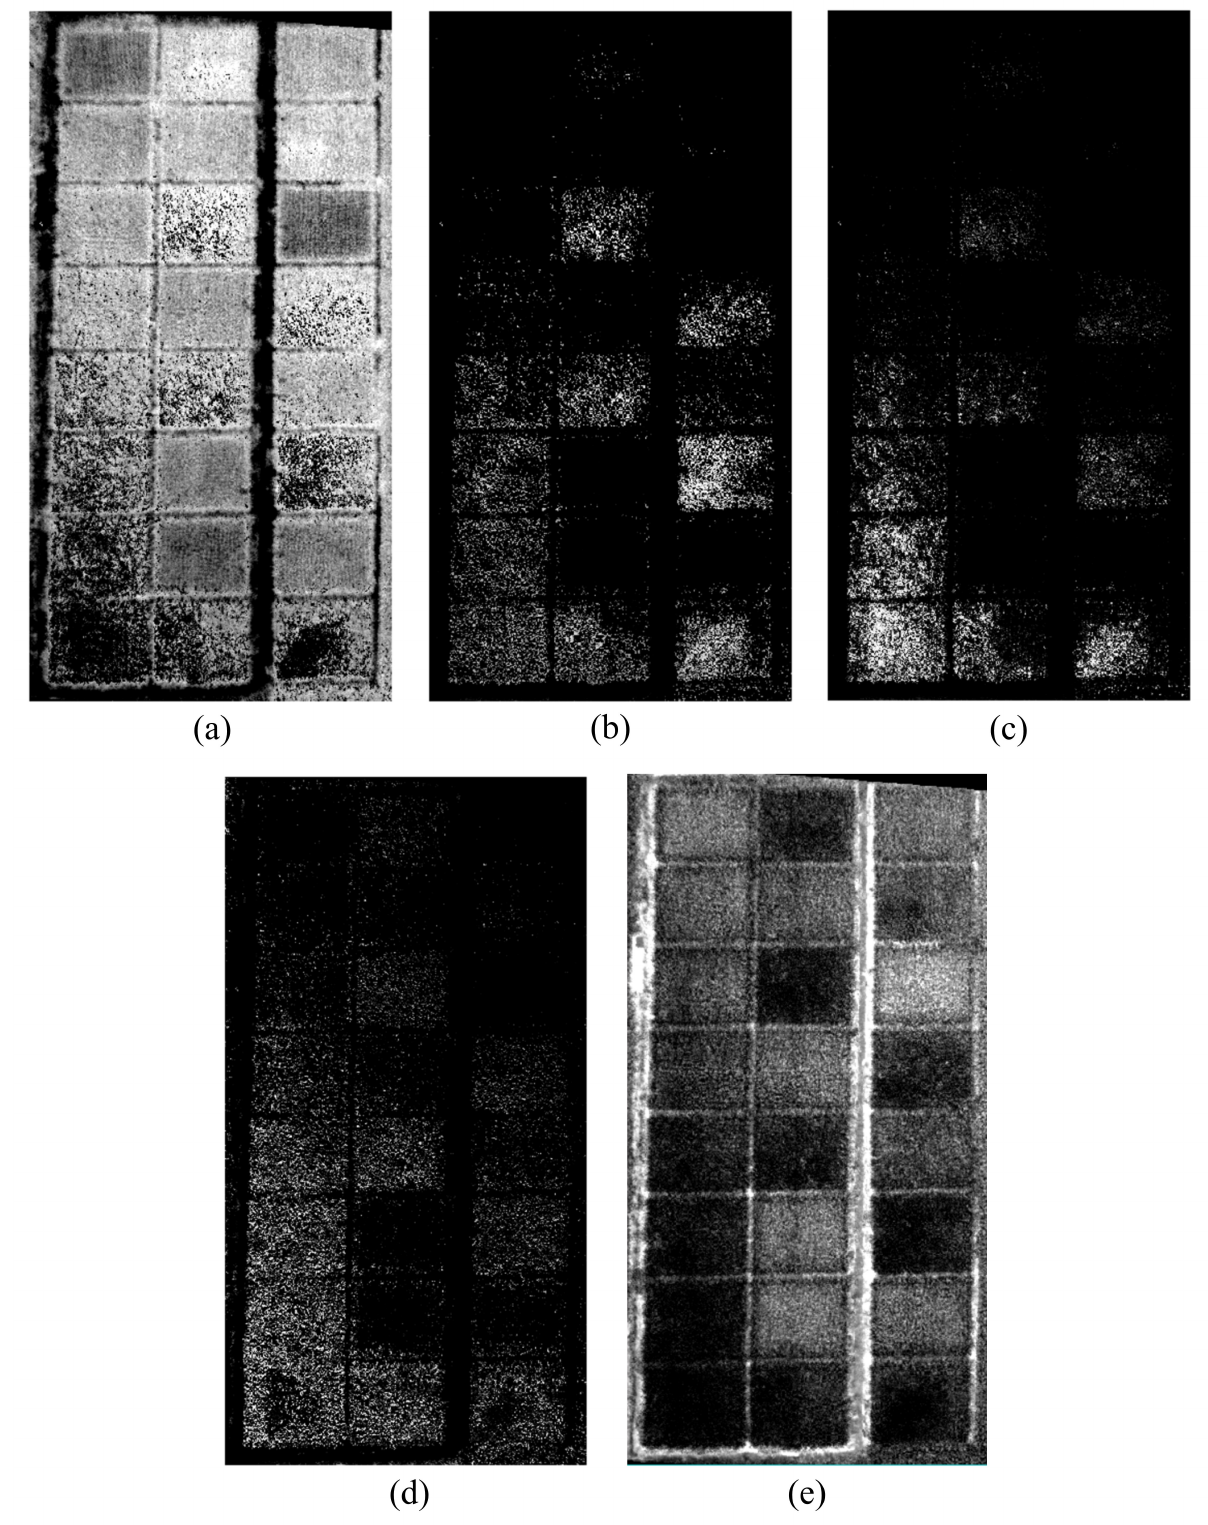
Figure 10. The abundance images of ( a – d ) five foreground and ( e ) one background endmembers of Study Area